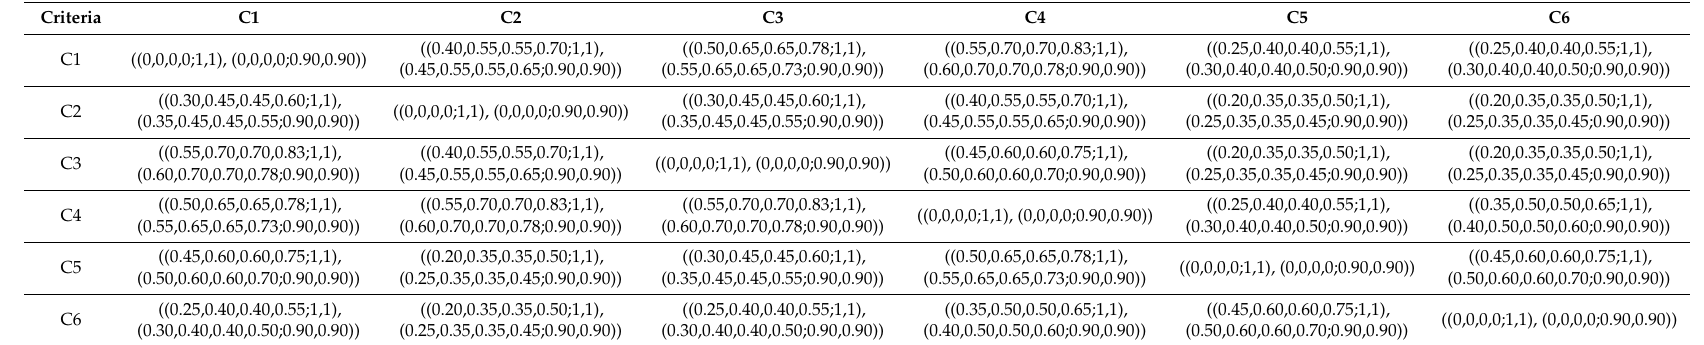
Table 6. Direct relation matrix for the criteria.